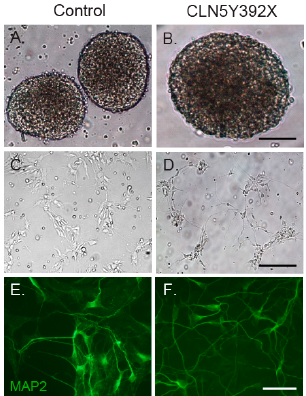
Figure 2. Neural differentiation of control and CLN5Y392X iPSC lines. iPS cells were differentiated into neural progenitor cells (NPCs), which grow as neurospheres in a suspension culture ( A , B ); Neurospheres were further differentiated on poly- L -ornithine/laminin-coated plates ( C , D ); At day seven, cultures were fixed and stained with the neuron-specific marker microtubule-associated protein 2 (MAP2) (green) ( E , F ); Bar 400 µm ( A , B ), 200 µm ( C , D ) and 50 µm ( E , F ).